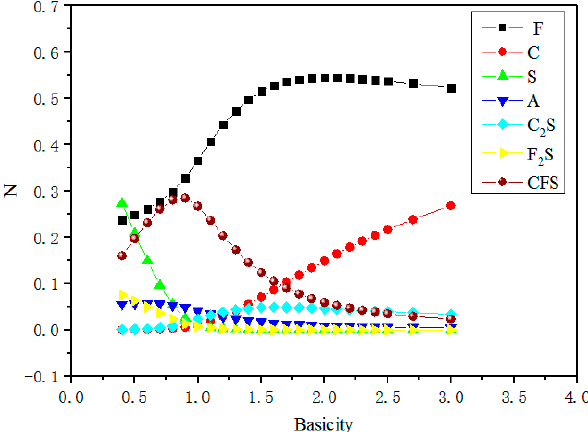
Figure 6. Activity of some components in slag 2 with different basicity, C 2 S, F 2 S and CFS, represent 2CaO · SiO 2 , 2FeO · SiO 2 and CaO · FeO · SiO 2 respectively.